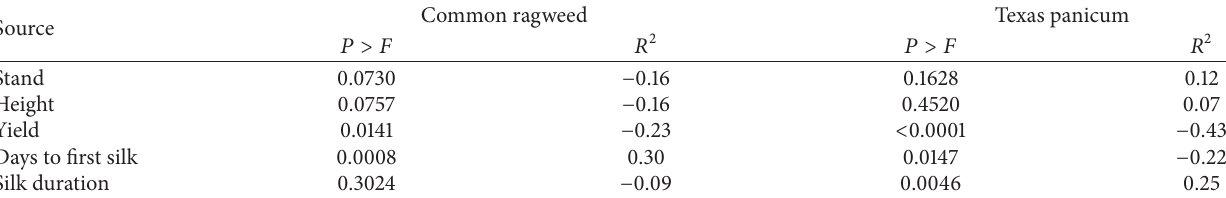
Table 5: Pearson correlations of common ragweed and Texas panicum density with corn growth and yield response at Lewiston-Woodville. Common ragweed Texas panicum Source 𝑃 > 𝐹 𝑅 2